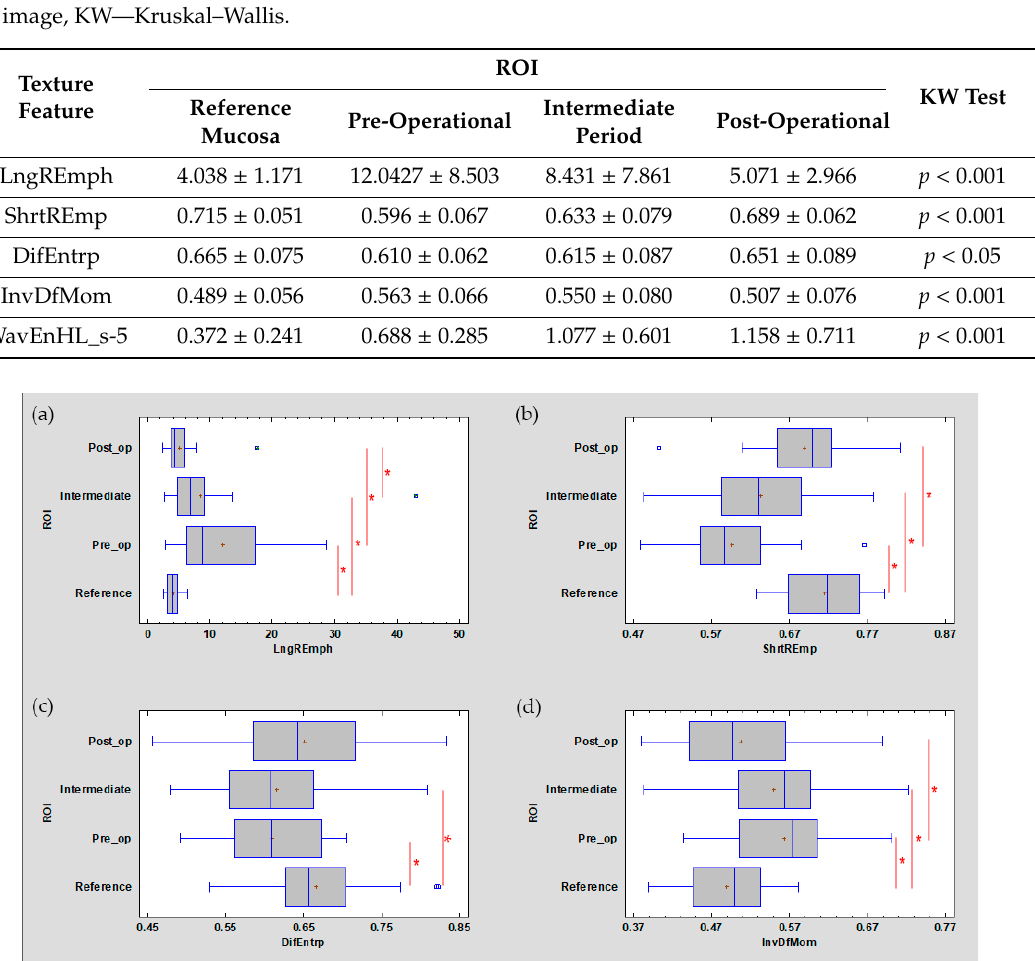
Figure 7. The analysed image texture features derived from the run-length matrix (( a ) LngREmph, ( b ) ShrtREmp) and co-occurrence matrix (( c ) DifEntrp, ( d ) InvDfMom). The values of all features presented here are returned after treatment to the value characteristic for the reference mucosal image. + average, blue vertical line indicates median, * significant difference ( p < 0.05).